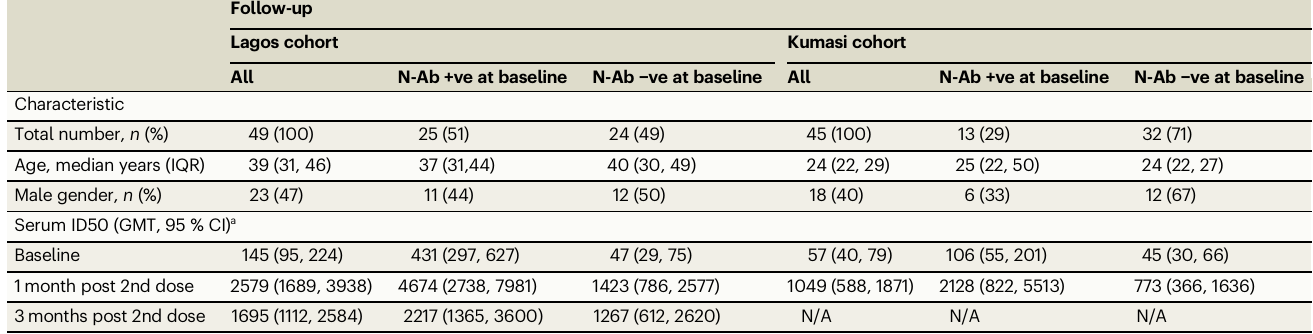
Table 1 | Baseline characteristics of study participants in longitudinal vaccine response study strati fi ed by IgG anti-N status